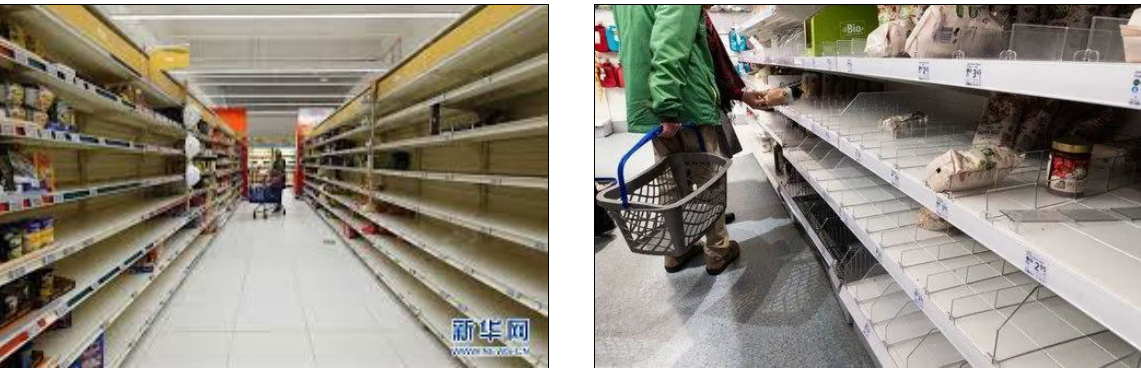
Photos 1 and 2. Empty Supermarket Food Stock in France and